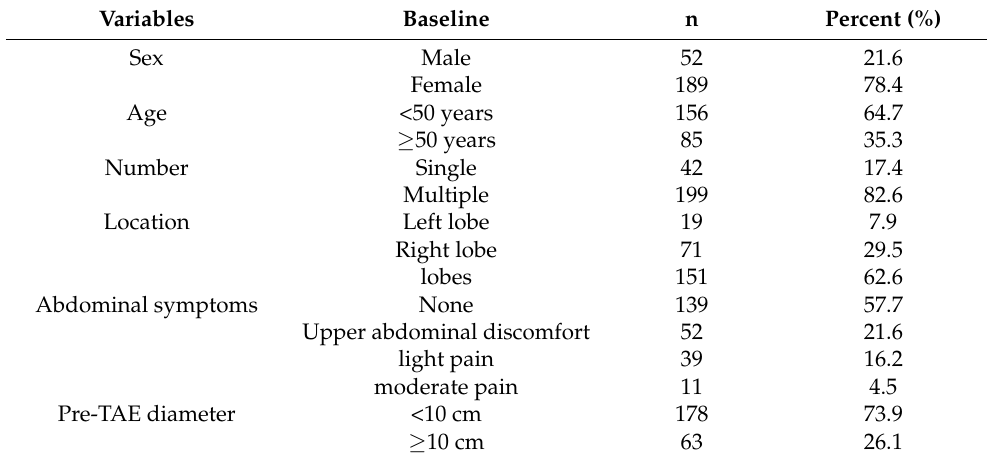
Table 1. Patients’ basic